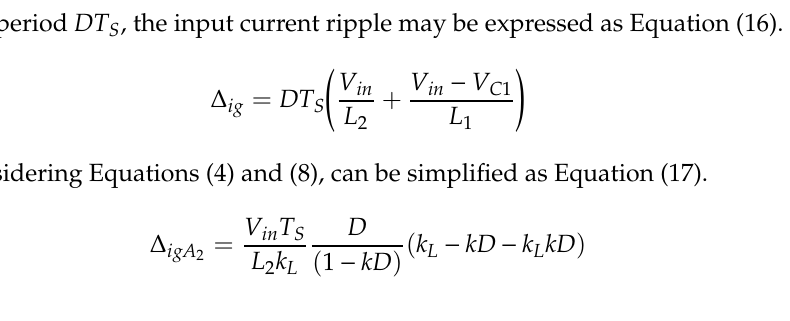
Figure 5. PWM important waveforms in the proposed converter when D < D Z .